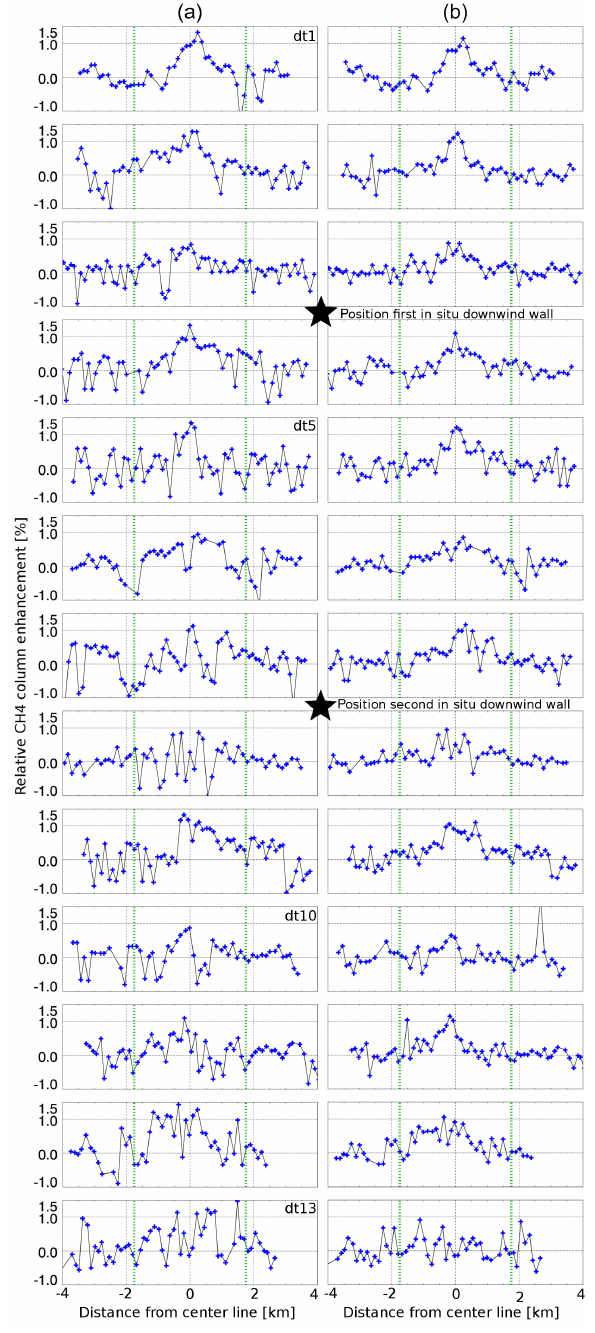
Figure 7. Shown are the 13 downwind tracks (filtered for detector filling and inclination, dt1 to dt13) from the MAMAP remote sur- vey over the Olinda Alpha Landfill on 1 September 2014, which were used for the emission rate estimate using Eq. (1). The x axis depicts the distance from the center line in kilometers (see also Fig. 6, white solid line) and the y axis gives the CH 4 column en- hancement relative to the background column. The area on the left ( − 4.0 to − 1.75km) and right ( + 1.75 to + 4.0km) side of the dot- ted green line was used for background normalization. (a) Non- corrected measurements. (b) Detector-filling-dependency-corrected measurements (see Sect. 3.1.2 for details).